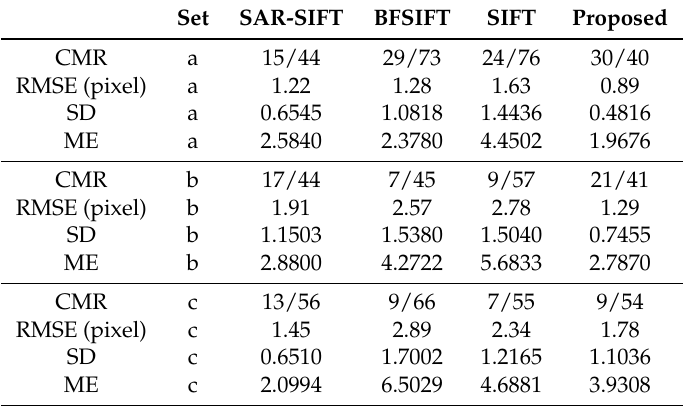
Table 2. Comparisons of SAR-SIFT, BFSIFT, SIFT and the proposed method.